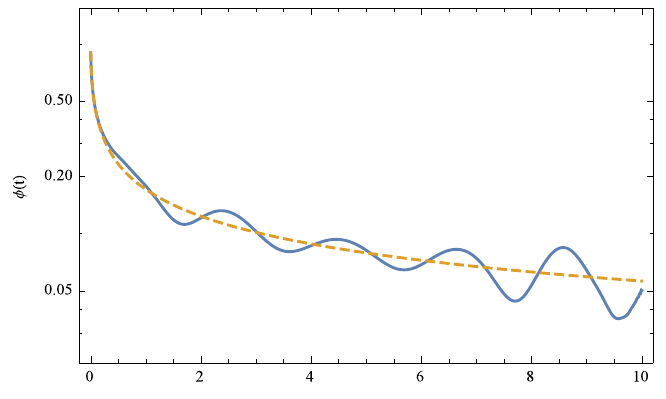
Figure 5. Approximations of the driven fractional relaxation Equation (88) (solid line). The initial condition and the relaxation time (cid:28) the fractional order (cid:12) was set to ϕ represents the solution of the relaxation Equation (84) using the same parameters. The Sinc approximation of the Caputo representation used N = 64 Sinc points.